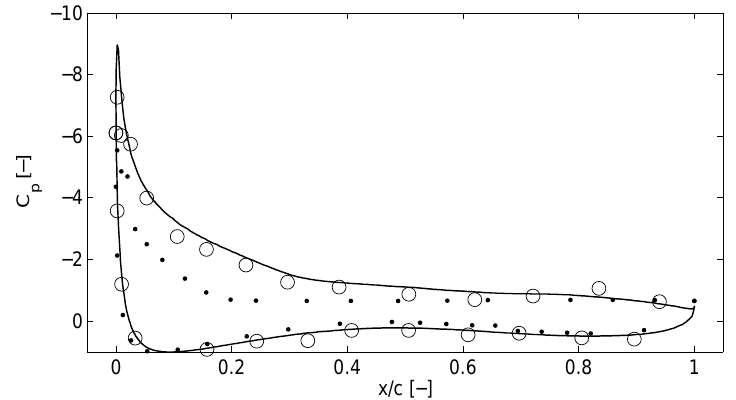
Figure 3. C distribution from r = 0 : 25 R for U 1 = 24 m/s, corresponding to AoA = 26 (cid:14) . p The dotted line represents 2D experimental results; the circles indicate 3D experimental results; and the full line shows 3D numerical